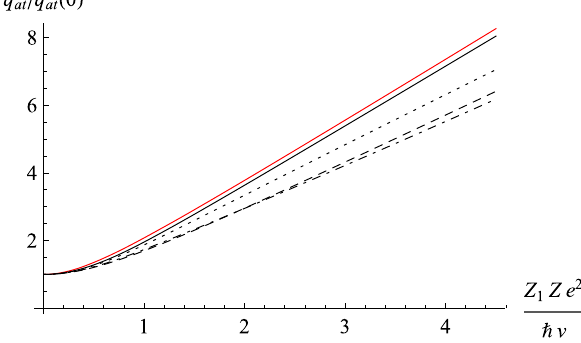
Fig. 5 Ratio (76) of the Molière screening angle to its Born value at Z Z 1 e 2 / ¯ h v → 0 [ χ at /χ at ( 0 ) = q at / q at ( 0 ) ]. Black solid curve, for Z = 1, also virtually the same for Z > 50. Dashed, Z = 2 (helium). Dot-dashed, Z = 4 (beryllium). Dotted, Z = 14 (silicon). Red solid (the uppermost) curve, Molière’s algebraic interpolation